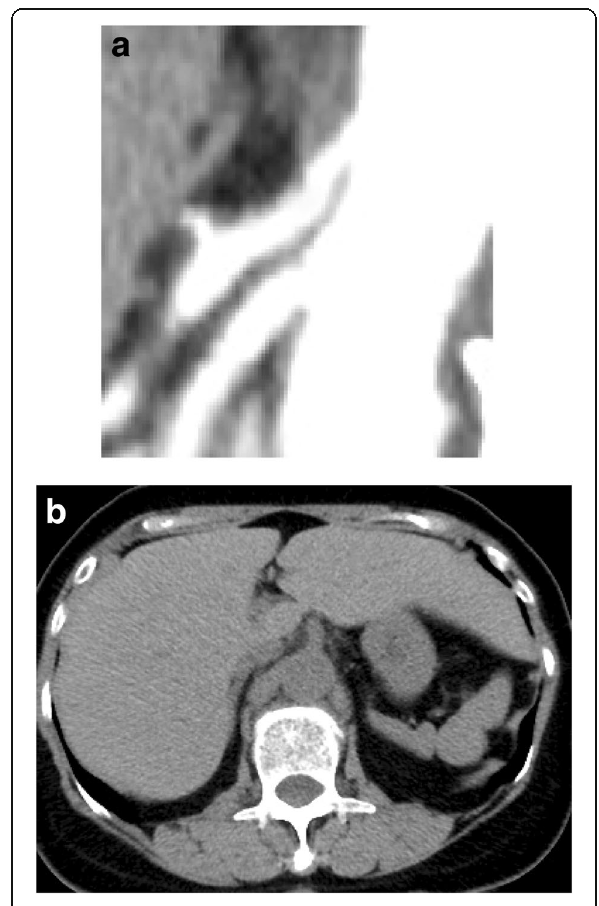
Fig. 1 Preoperative multidetector CT showing neither median arcuate ligament syndrome nor arteriosclerosis around the celiac artery. a Contrast-enhanced CT. b Plain